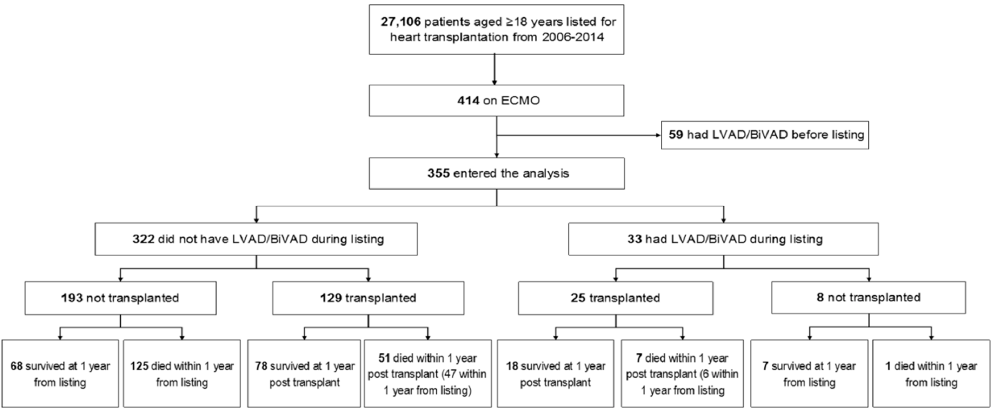
Figure 1. Study algorithm showing outcomes of patients listed on VA-ECMO. VA-ECMO: veno-arterial extracorporeal membranous oxygenation; ECMO: extracorporeal membranous oxygenation; LVAD: left ventricular assist devices; BiVAD: biventricular assist device. Table 1. Ventricular assist devices types. VAD Brand